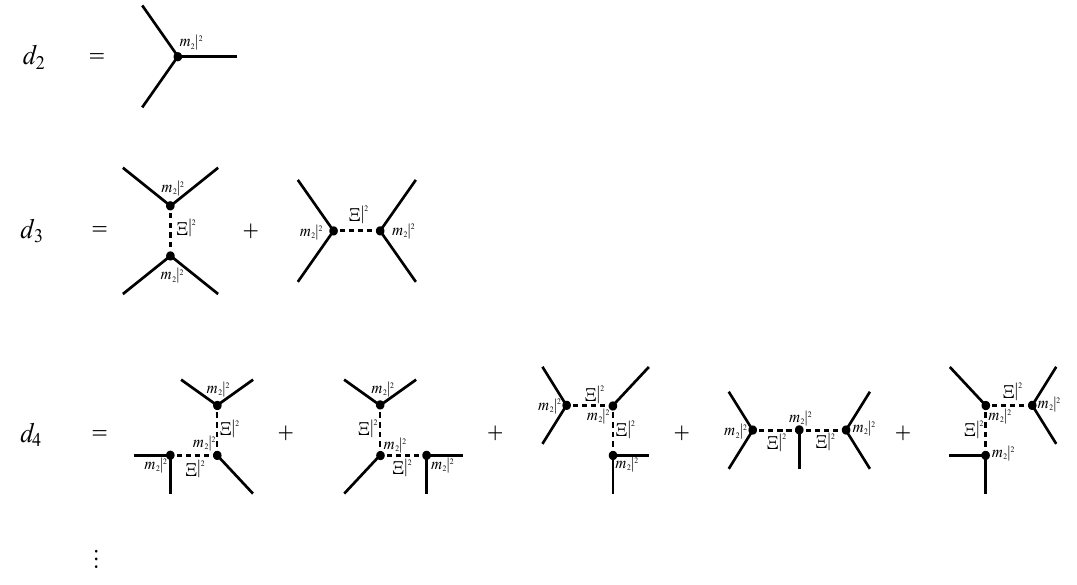
Figure 2 . Feynman diagram expansion of the products of d . We can choose output of the product d n to correspond to be the external leg in the left hand corner, and the 1st through n th inputs to correspond to the other external legs proceeding counterclockwise. In this case, the diagrams correspond in order to the terms written in